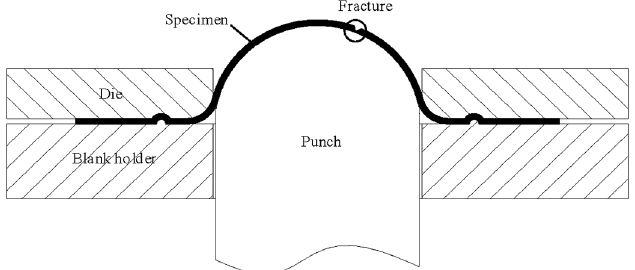
Fig. 7. Experimental schematic diagram of Nakajima rigid hemispherical punch Bulge-Forming.